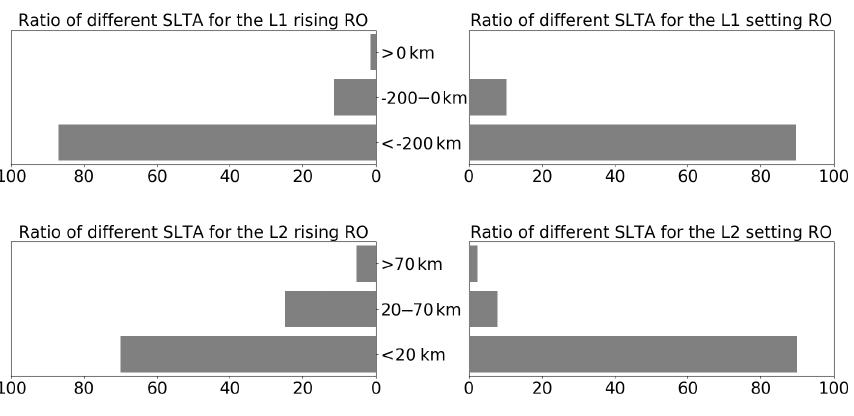
Figure 2. Ratio of different SLTA of the L1 C/A and L2 P for the rising and setting occultations. The statistical result is from 28 January to 2 February